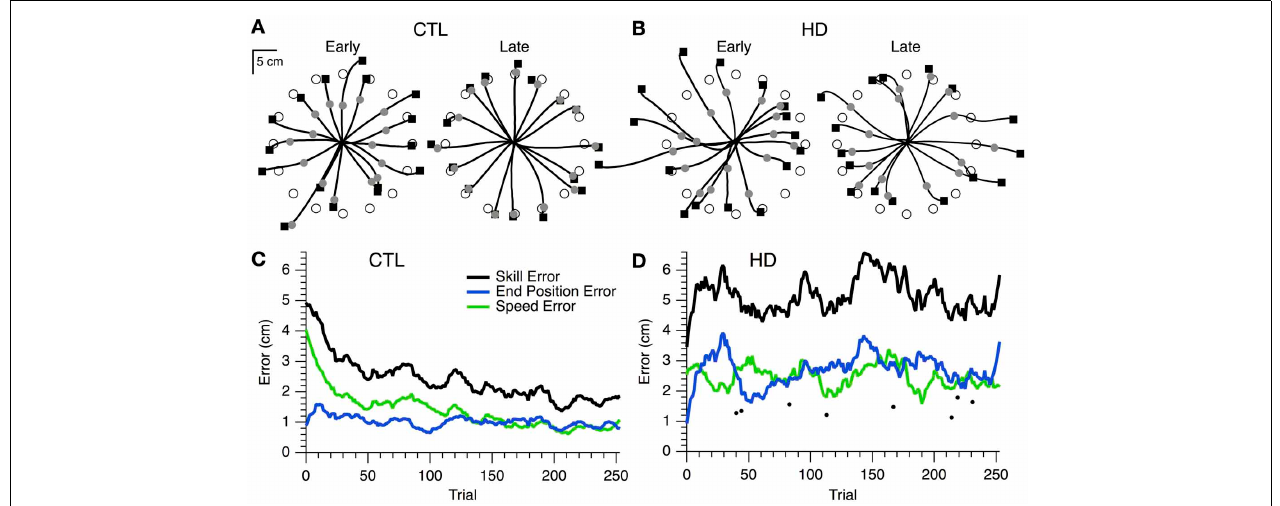
FIGURE 2 | Hand paths and time course of skill learning for representative single subjects. (A) Hand paths for a sample CTL subject with the positions of the timed discs (gray circles) and endpoint squares (black squares) shown. “Early” trials (i.e., the first 16 trials of training), left. “Late” trials (i.e., the last 16 trials of training), right. (B)